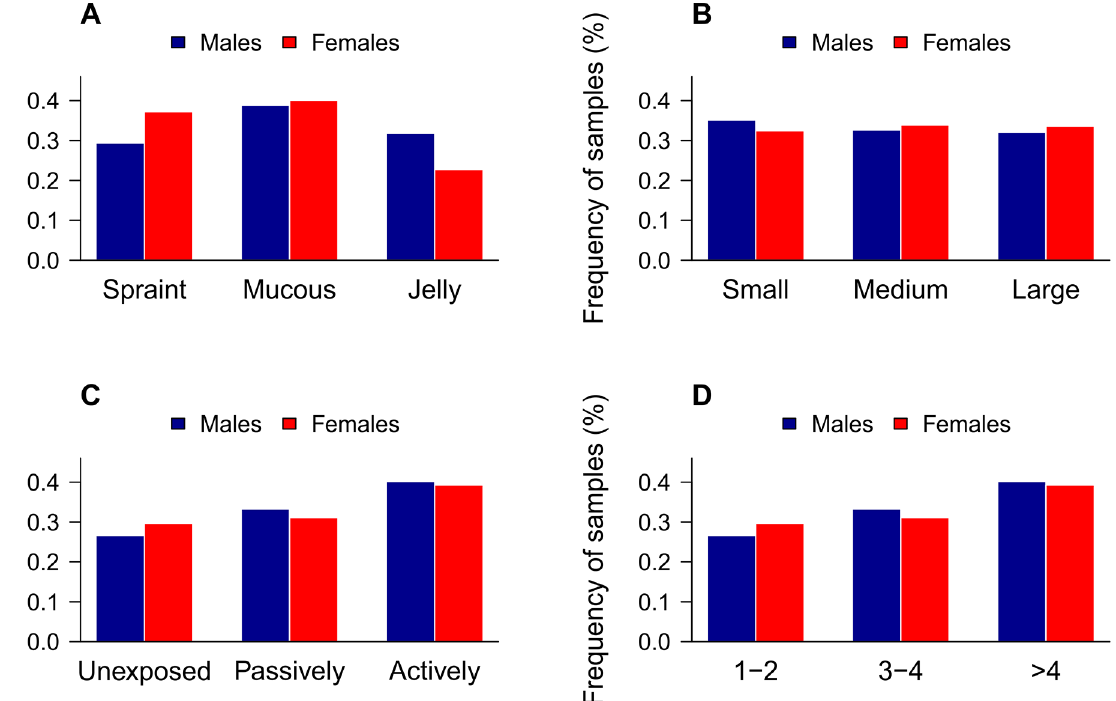
Fig 2. Sex differences in otter marking behaviour. Frequency of genotyped otter samples regarding (A) their sliminess (spraint, spraint plus mucus, jelly samples), (B) their size (small, medium, large), (C) their level of exposedness (non-exposed, passively exposed, actively exposed), and (D) the number of otter faeces at the specific marking site (1 – 2, 3 – 4, > 4 samples); all four separated by sex. Only sliminess showed a significant sex difference in a Pearson ’ s chi-squared test ( χ 2 = 9.6, df = 2, p -adjusted =